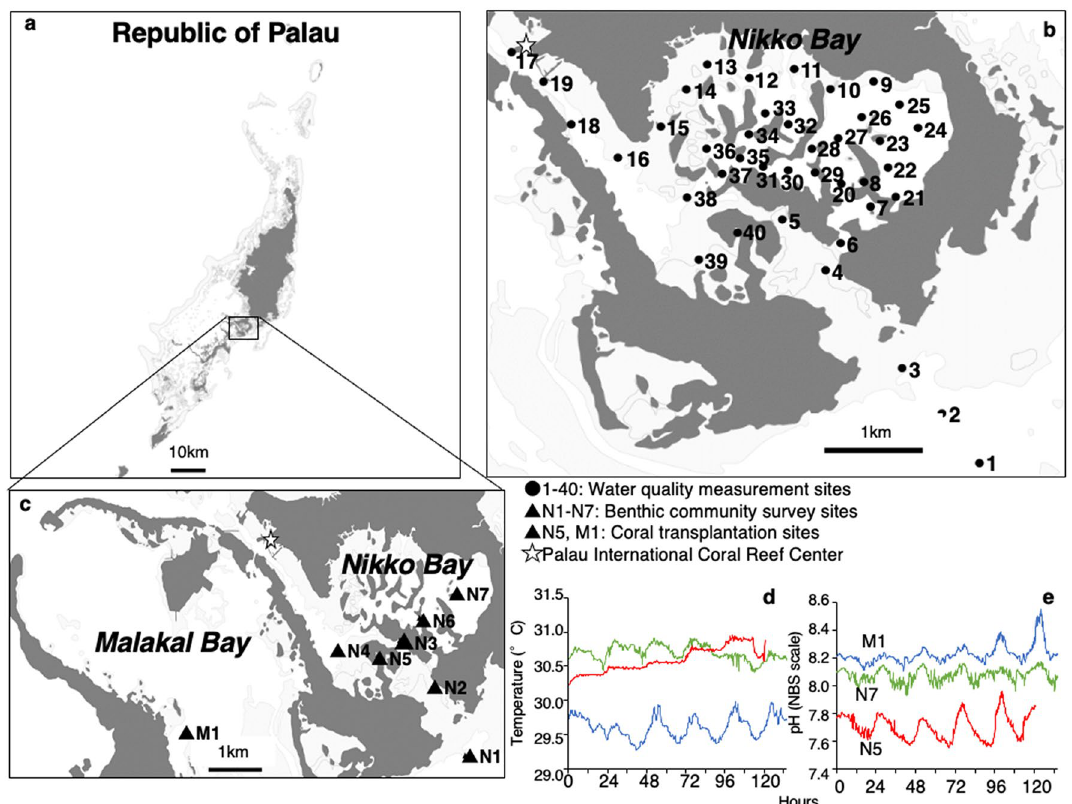
Figure 1. Map showing study sites and seawater temperature and pH at 3 sites (M1, N7, N5). ( a ) Map of the Republic of Palau. ( b ) The 40 locations where seawater quality was measured around Nikko Bay. ( c ) The seven sites (N1-N7) where benthic communities were surveyed and the reference site at Malakal Bay (M1) where the coral Porites cylindrica experiment was conducted. The coral P. cylindrica was sampled from sites M1 and N5 for reciprocal transplantation experiment. ( d ) Diurnal seawater temperature and ( e ) pH (total scale) measured at Malakal Bay (M1) and two sites at Nikko Bay (N7 and N5). The figure was created using QGIS 3.8.1 (https:// www. qgis.